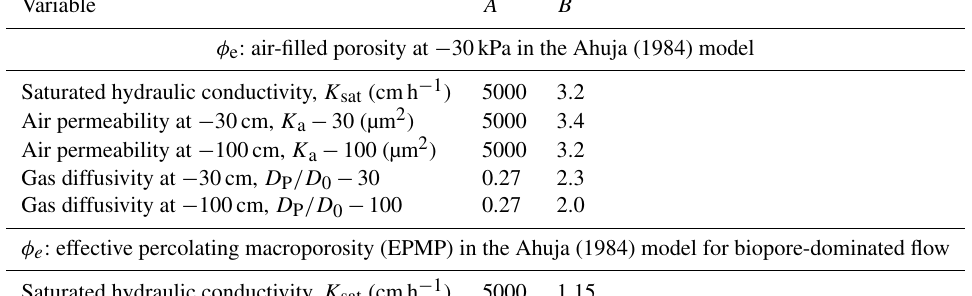
φ e : effective percolating macroporosity (EPMP) in the Ahuja (1984) model for biopore-dominated flow Saturated hydraulic conductivity, K sat (cmh − 1 )